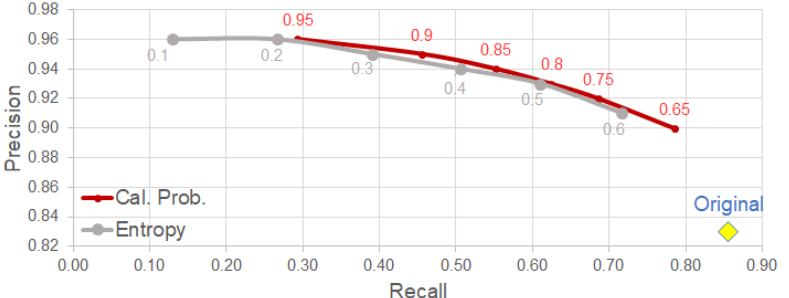
Figure 8. Precision vs. Recall plot for uncertainty selection on ESDB dataset. The original model is WiderNet 8 × , FCN 128 with Bayesian approach and no selection. Please note that a threshold of 0.65 on the cal. prob. yields about an equal percentage of increase in precision and decrease in recall. Best in color.